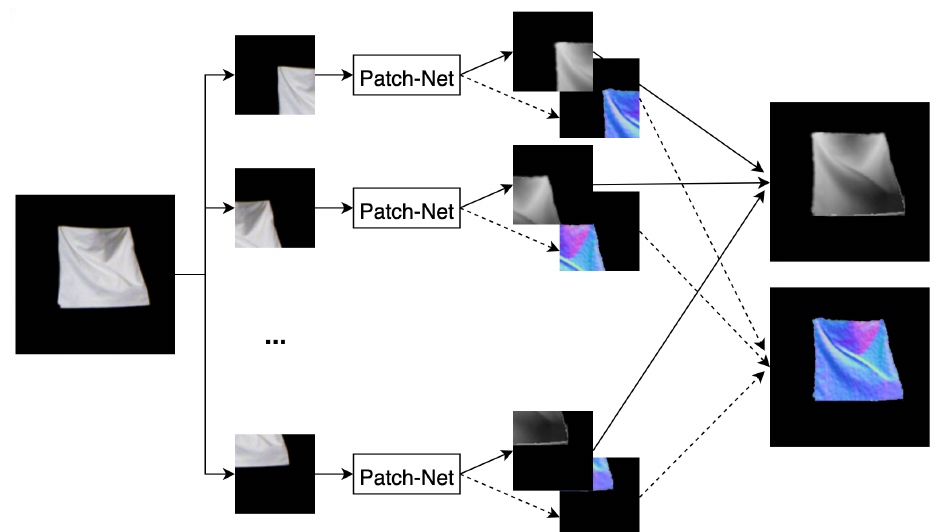
Figure 4. Patch-Net uses Bednarik et al. [3]’s network with only depth and normal decoders. The input image is divided into overlapping patches, and predictions for each patch are obtained separately. Patch predictions are stitched to form the complete depth and normal maps .